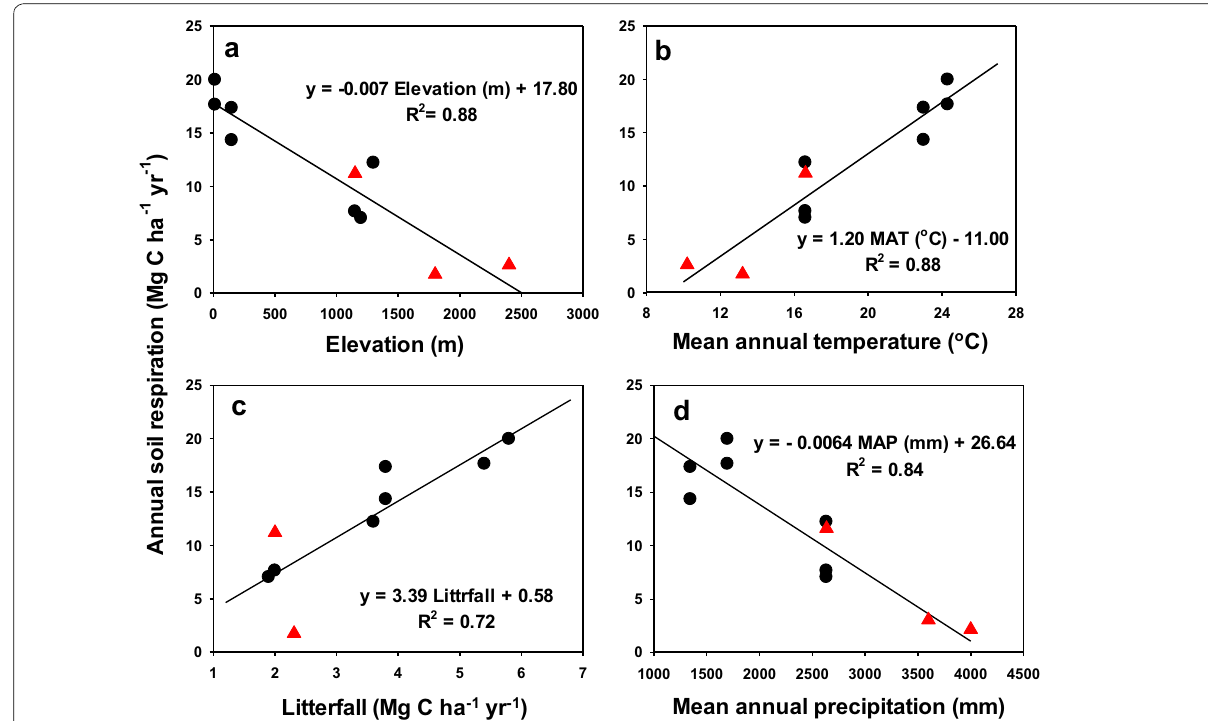
Fig. 4 Linear relationships of annual soil respiration with a elevation, b mean annual temperature, c litterfall, and d mean annual precipitation in Taiwan. Black circles refer to the current study and red triangles refer to previous studies (Chang et al. 2001; Kuo and Chang 2009; Hsieh et al.